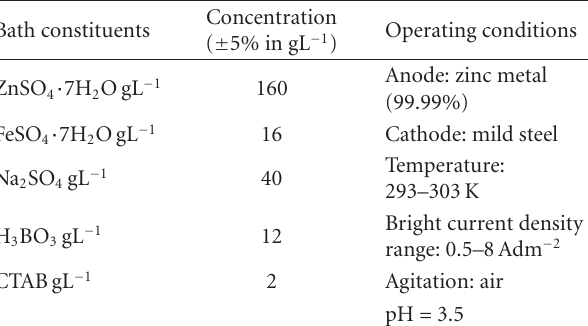
Table 2: Optimum bath composition and conditions. Bath constituents